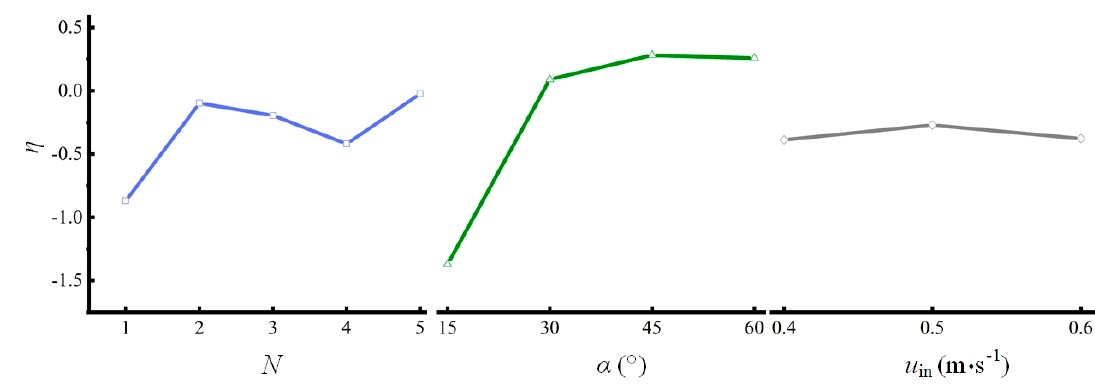
Figure 8. Relationships between the efficiency of the L/D cycle enhancement and three factors (double-sided illumination).